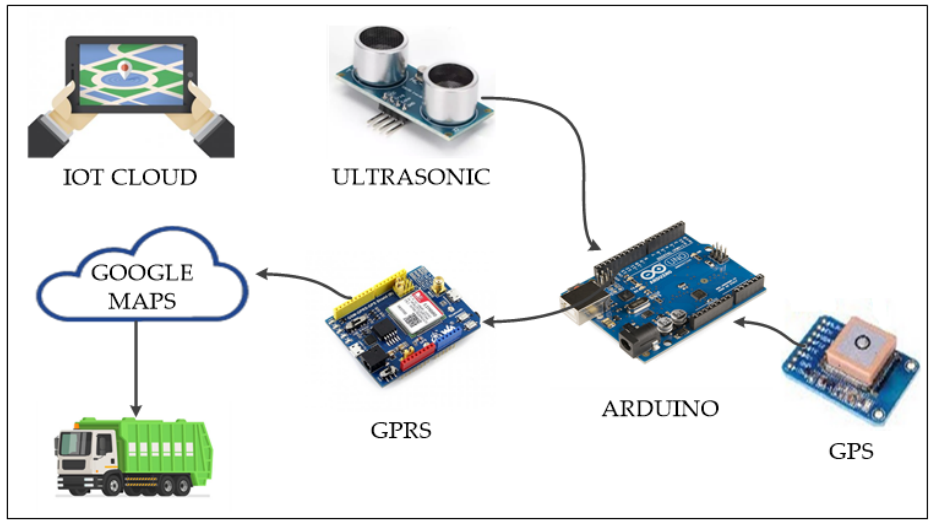
Figure 1. IoT based waste management system.